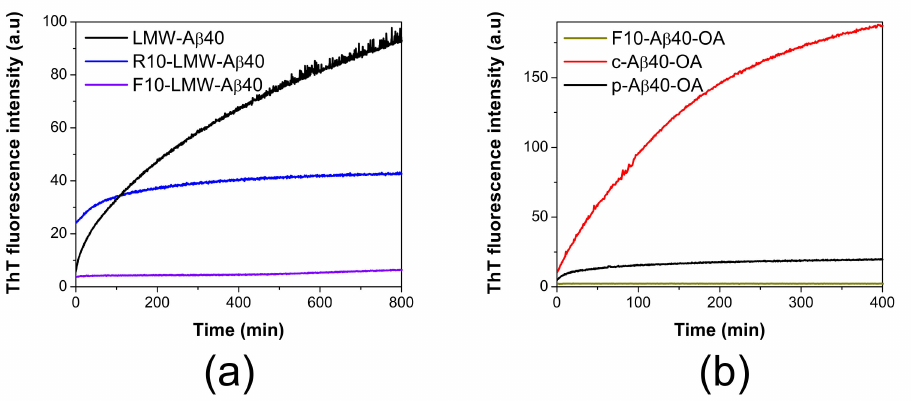
Figure 1. ThT aggregation kinetics of different A β 40 species. ( a ) Representative aggregation kinetics of LMW-A β 40 at 90 µ M (black line), R10-LMW-A β 40 at 90 µ M (blue line) and F10-LMW-A β 40 at 50 µ M (violet line) followed by ThT fluorescence at 37 ◦ C. ( b ) Comparison of the aggregation kinetics of c-A β 40-OA (red line) and p-A β 40-OA (black line) at 24 µ M and F10-A β 40-OA (grey line) at 10 µ M followed by ThT fluorescence at 37 ◦